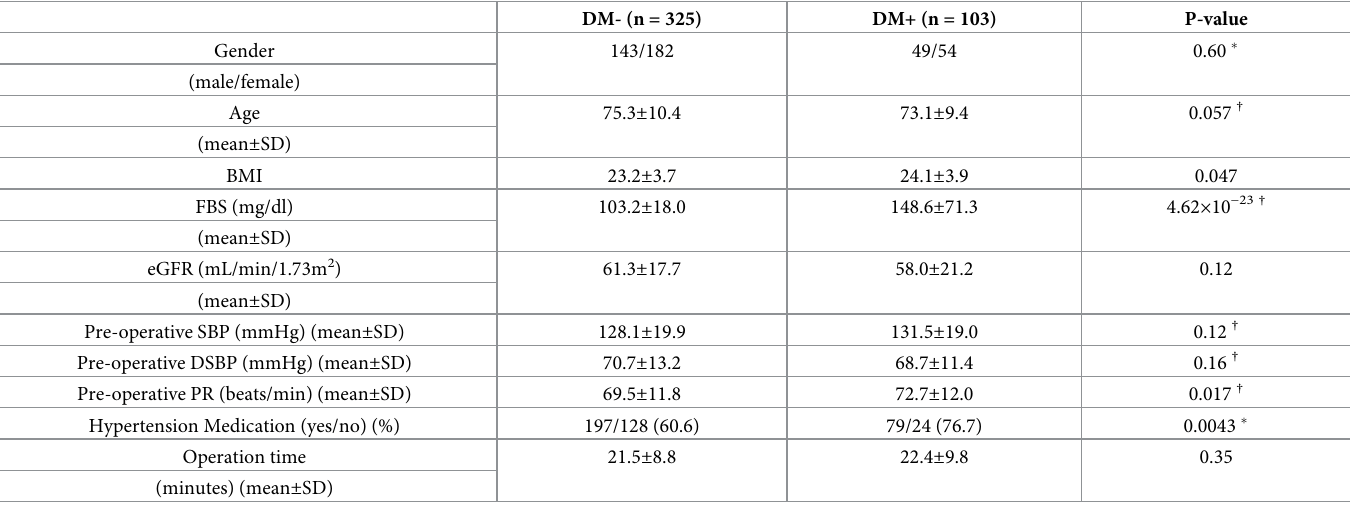
Table 1. Clinical characteristics of the patients with or without